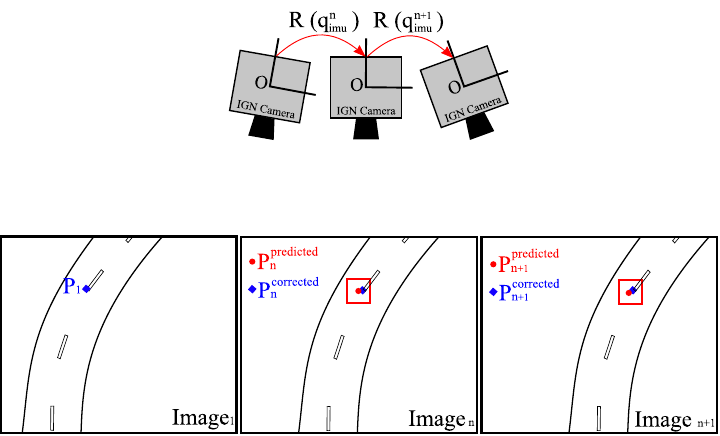
Figure 10. Rotation between three images.